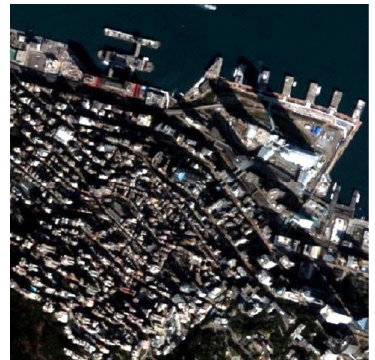
Figure 2. Typical urban area in Hong Kong -Central (Quickbird image)